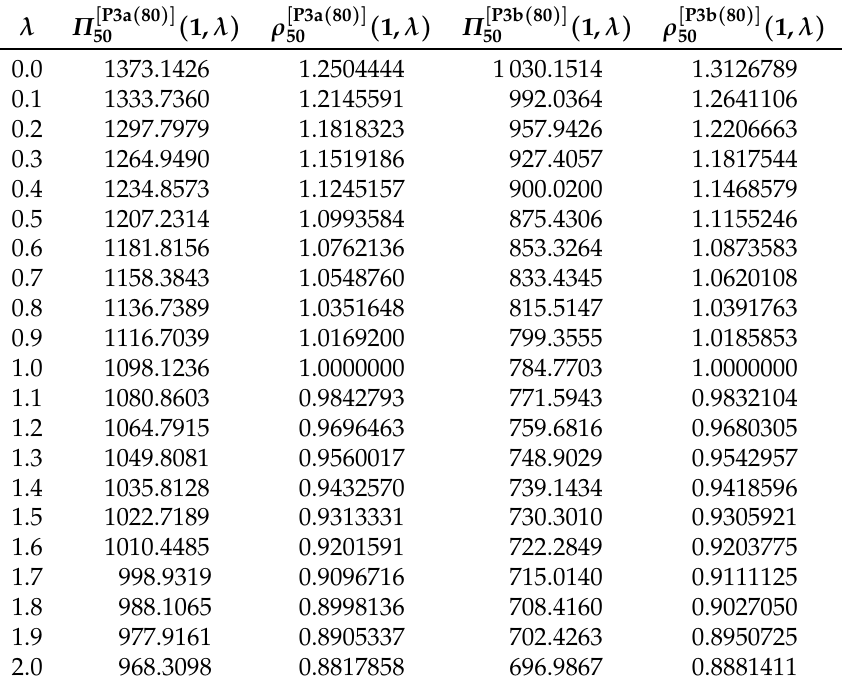
Table 15. Products P3a, P3b (insurance packages); x = 50, C = 1000, b (cid:48) = 50, b (cid:48)(cid:48) = 150.